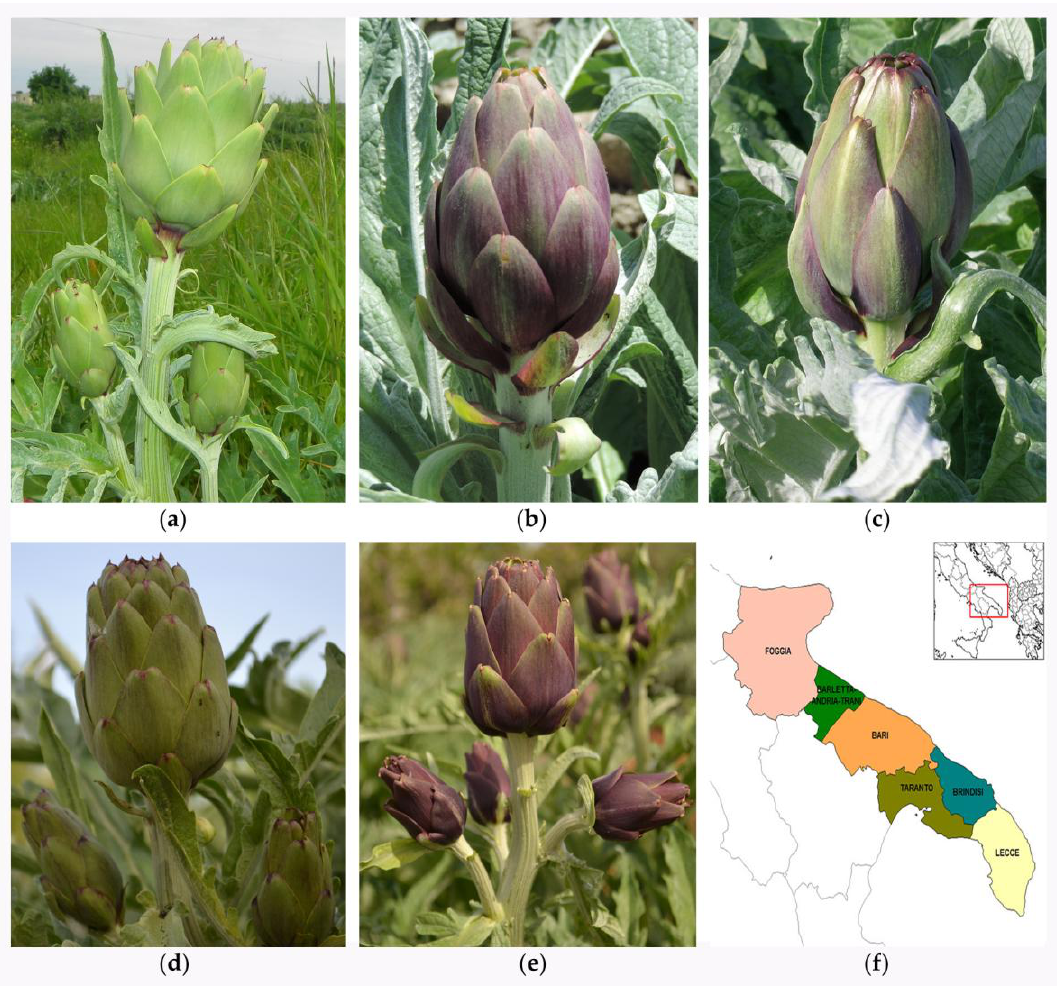
Figure 1. Apulian artichoke ecotypes subjected to sanitation from virus infection by meristem-tip and thermotherapy ( a ) “Bianco di Taranto”; ( b ) “Francesina”; ( c ) “Locale di Mola”; ( d ) “Verde di Putignano”; ( e ) “Violetto di Putignano”; ( f ) Map of province sub-areas of Apulia region. (Photo ( a , b , d , e ) courtesy of Dr. Gabriella Sonnante, CNR IBBR collection, Bari, Italy; photo ( c ), courtesy of Prof. Pietro